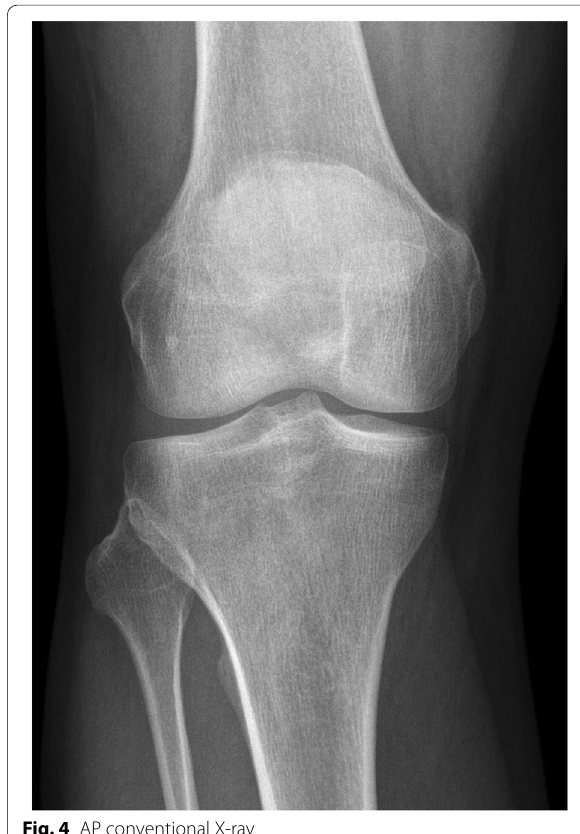
red point: centroid ACL tibial footprint, yellow point: the styloid process of fibular